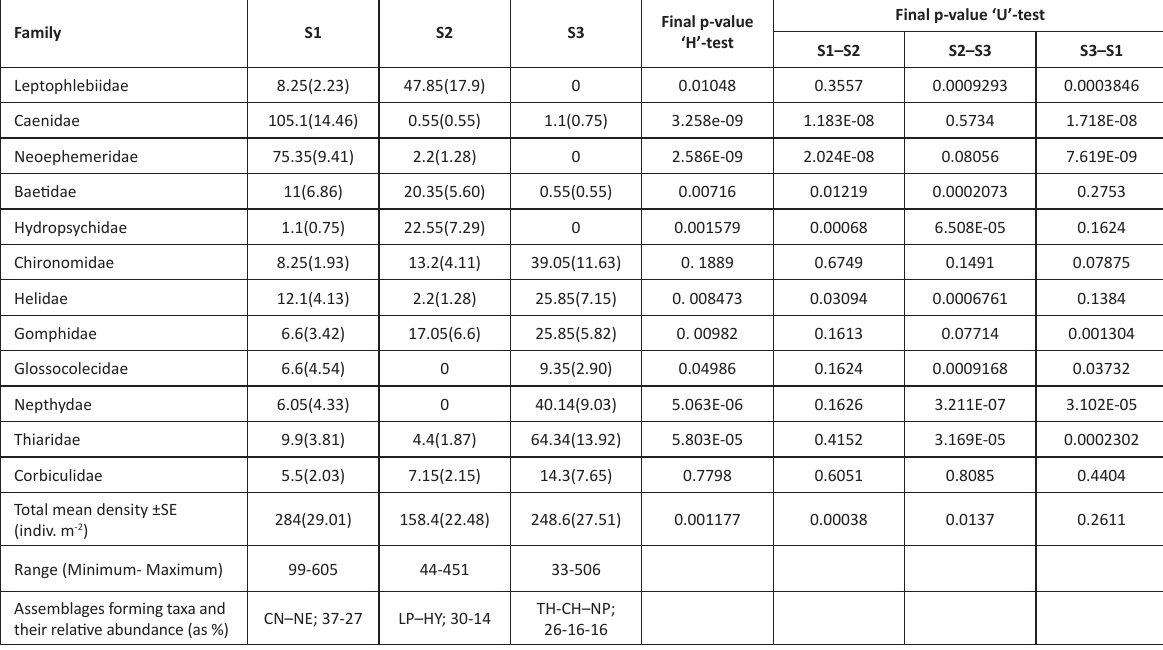
Table 2. Benthic macroinvertebrate community: Total density (mean, SE) in different land uses in Ken River. density is calculated from 20 quadrants data for each land use. Mann–Whitney tests (u-test) determines significant difference in mean densities (indiv. m -2 ) in the families present for pair of land use in the Ken River. (df = degree of